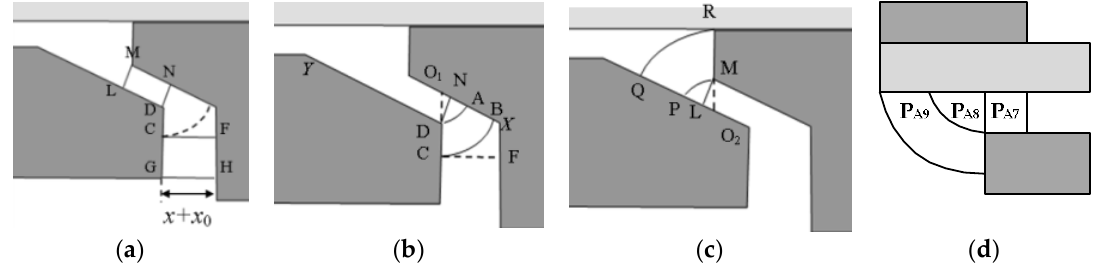
Figure 7. Air gaps magnetic flux path: ( a – c ) front end; and ( d ) rear end.